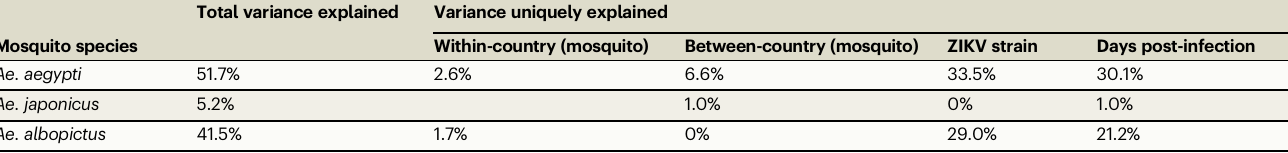
Table 1 | Contribution of random effects and fi xed effects in species-wise regression